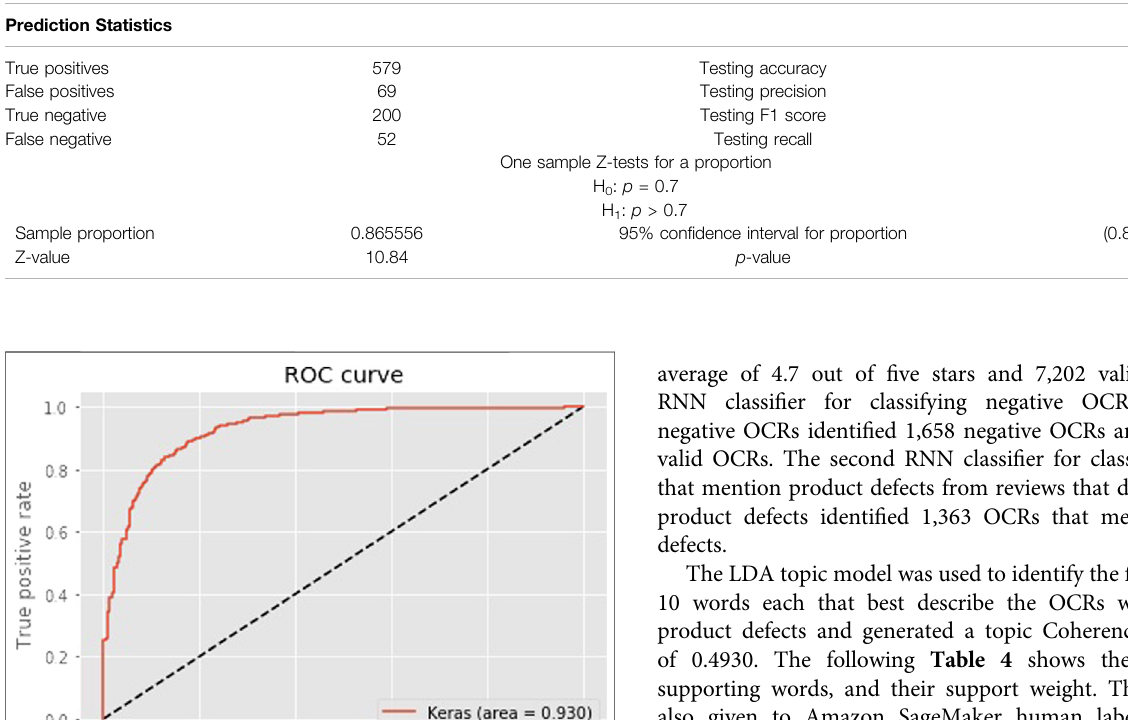
Frontiers in Applied Mathematics and Statistics |